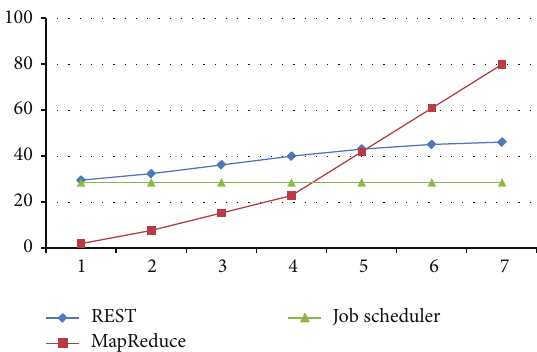
Figure 9: Utilization of REST web server, MapReduce clusters, and Job